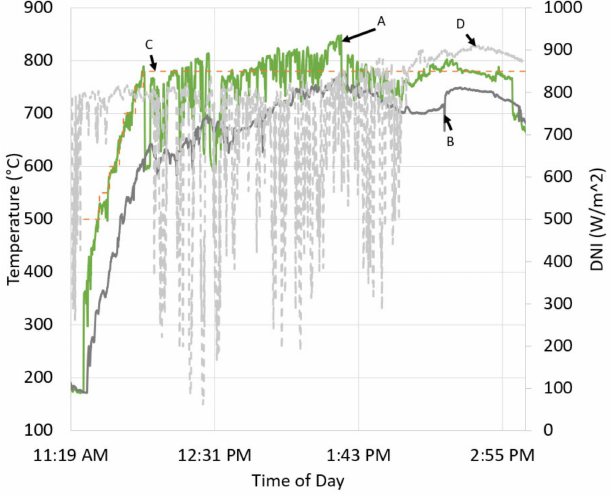
Figure 12. Receiver outlet temperature controller response to significant fluctuations in DNI; receiver outlet temperature A, receiver inlet temperature B, and receiver outlet temperature setpoint C and the DNI during testing D